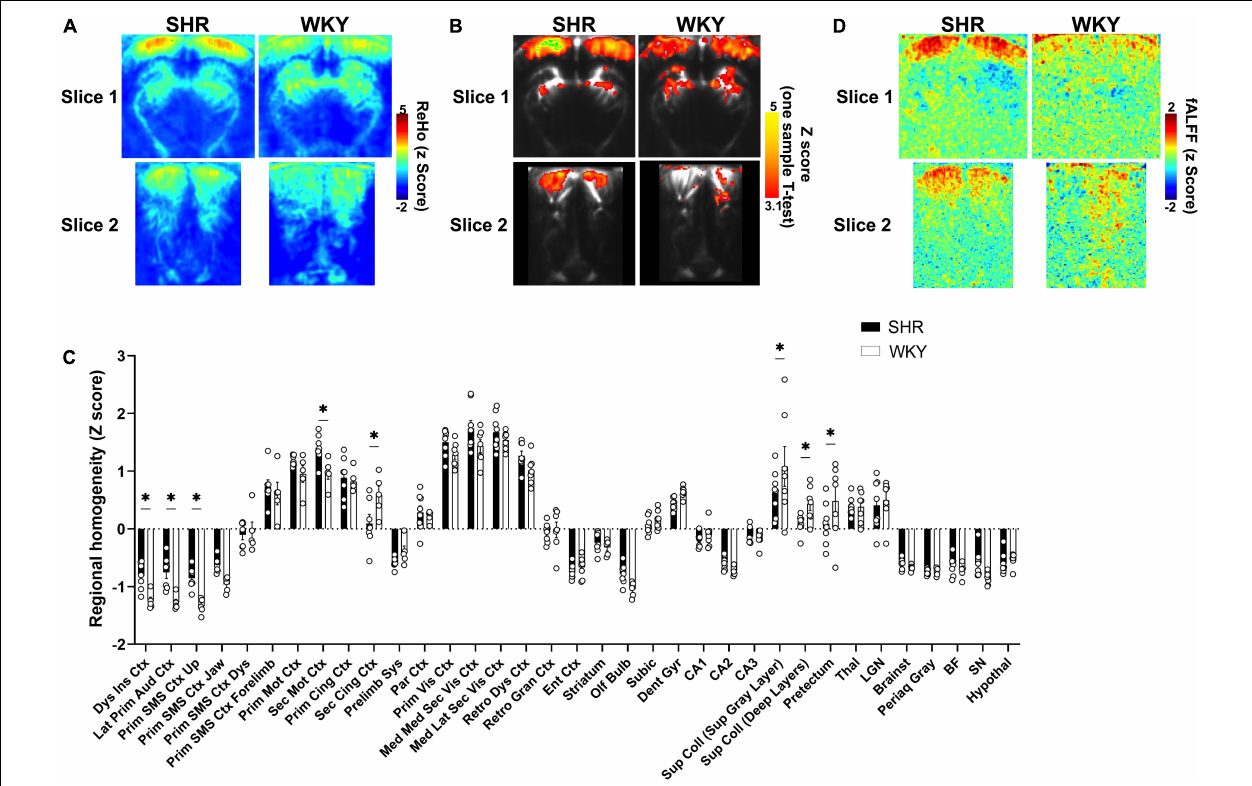
FIGURE 3 | Resting-state local functional connectivity in SHR and WKY rats. Averaged (A) and statistical (B) maps of resting-state brain regional homogeneity (ReHo) pattern in SHR and WKY rats ( p < 0.001 in B ). (C) with a FDR of 0.1 (*). (D) Averaged map of resting-state fractional amplitude of low-frequency fluctuations (0.01–0.08